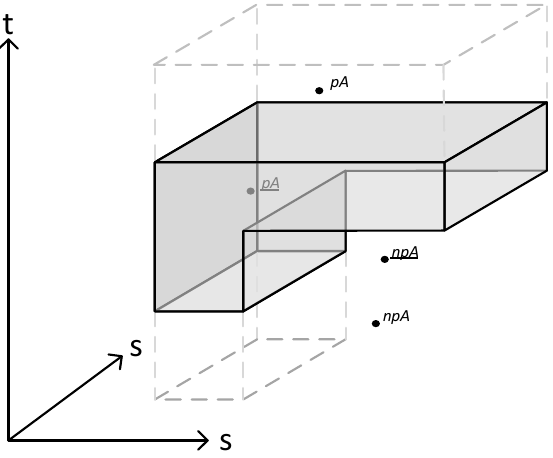
Figure 5. Symbolization of the four possible spatio-temporal states of an individual with regard to the context of the organization of a conference, considered as a workspace. An individual can be present during the activity of the conference ( pa ), present during the period of activity of the conference ( pa ), non-present during the occurrence of the conference ( npa ), and finally, non-present during the inactivity of the conference ( npa ).